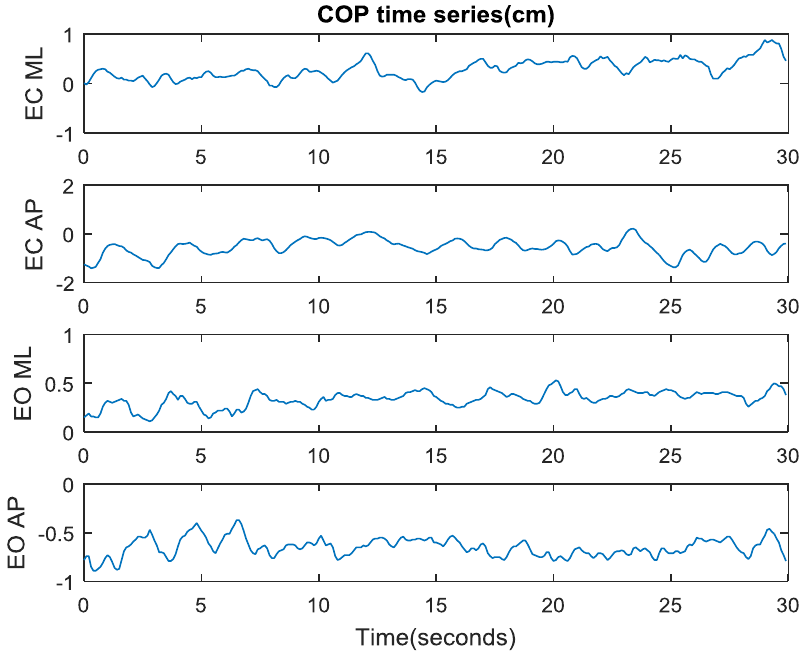
Figure 6. COP time series (represented by the vertical axis in cm) along the ML and AP directions with/without visual feedback during quiet, upright standing.